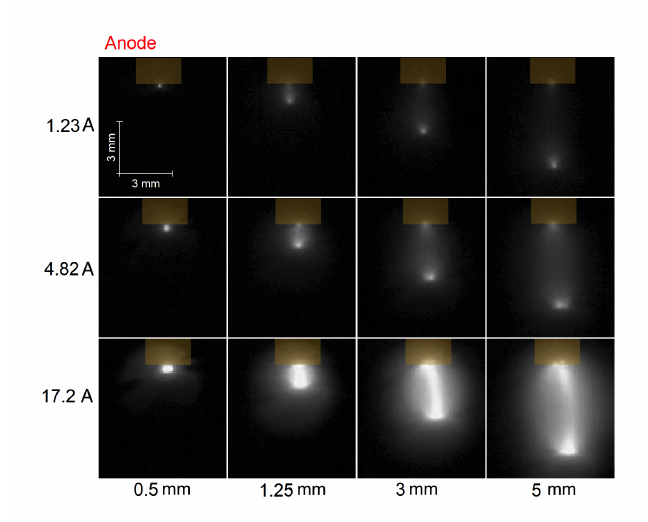
Figure 5. High-speed images of an arc at multiple lengths and currents for Type-2